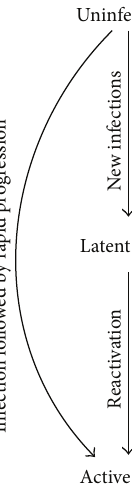
Figure 1: A simple epidemiological model of TB. Uninfected individuals that are exposed to TB can become infected with TB, which can result in either a long-standing infection that is asymptomatic and noninfectious (latent TB) or progress at some point (“reactivation”) to a condition that is infectious and generally symptomatic (active TB). Detection and effective treatment can cure active TB. For simplicity, some other important features of natural history of TB are not shown here (but are generally included in compartmental models of TB), including reinfection, spontaneous resolution (“self-cure”), and